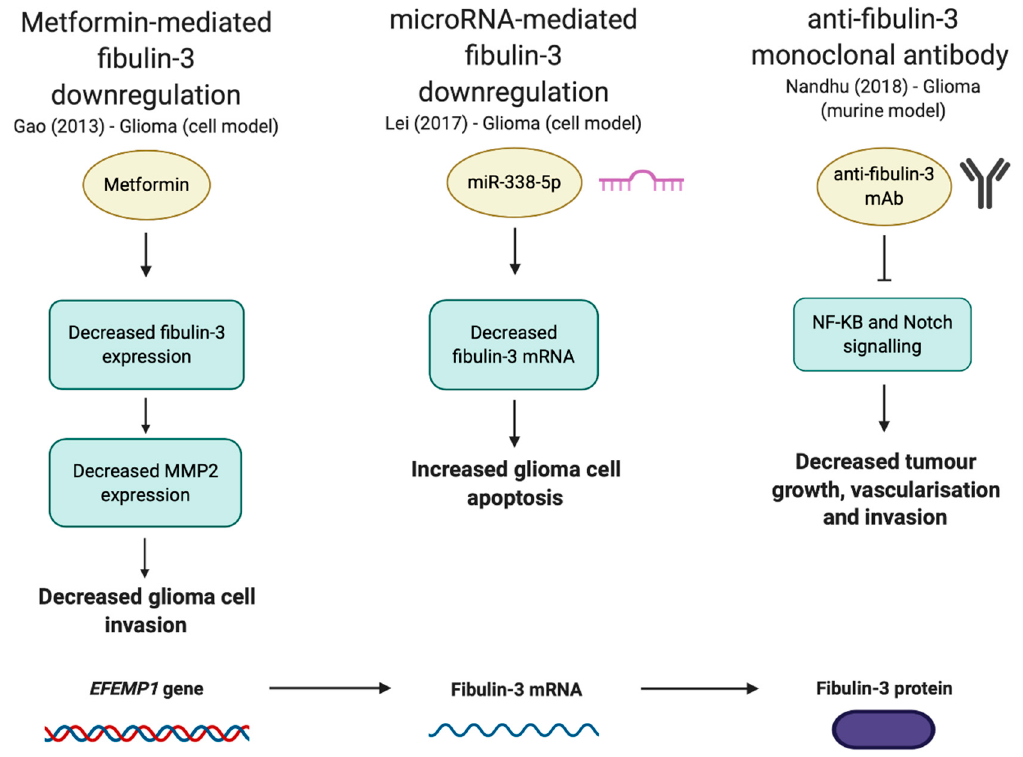
Figure 6. Putative fibulin-3-oriented therapeutic strategies for glioma.